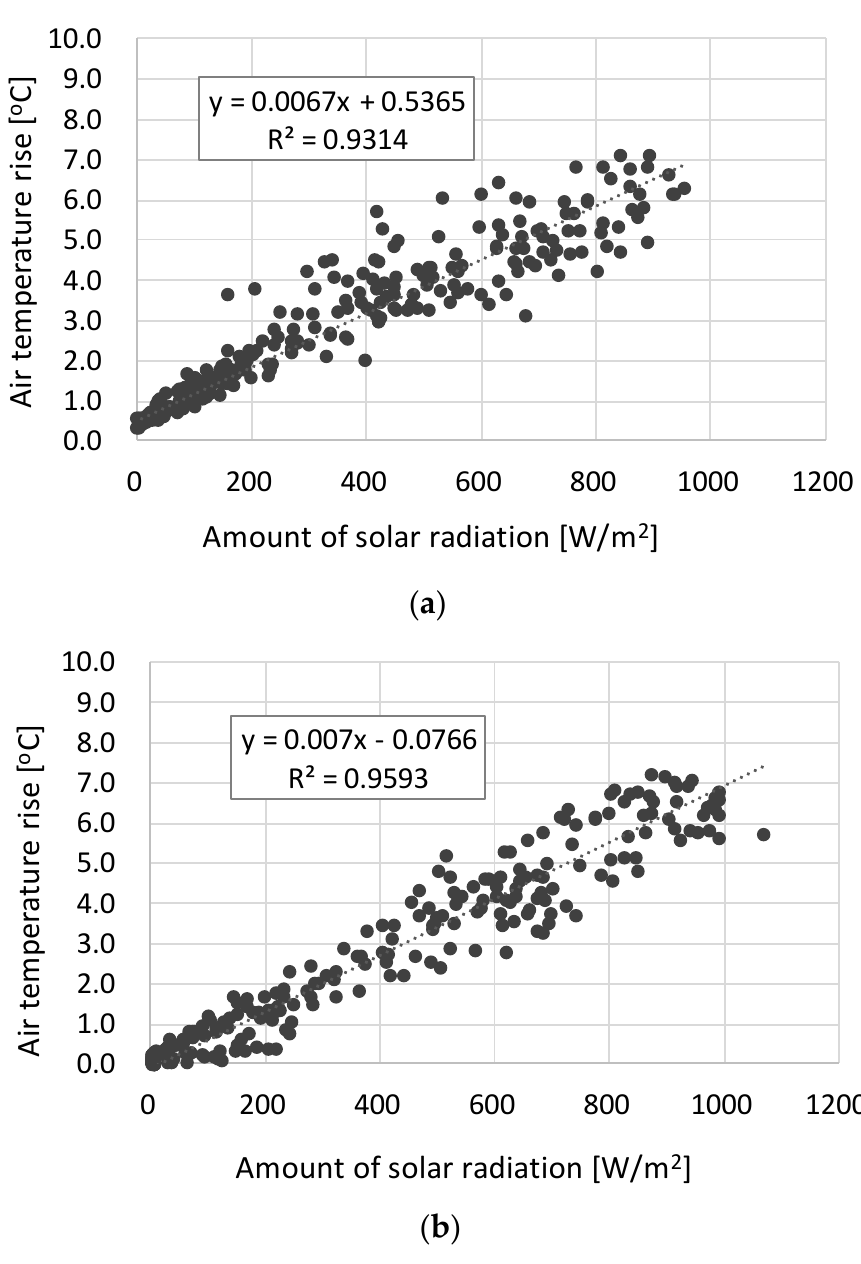
Figure 6. Relationship between insolation and outlet temperature rise: ( a ) summer; ( b ) winter.